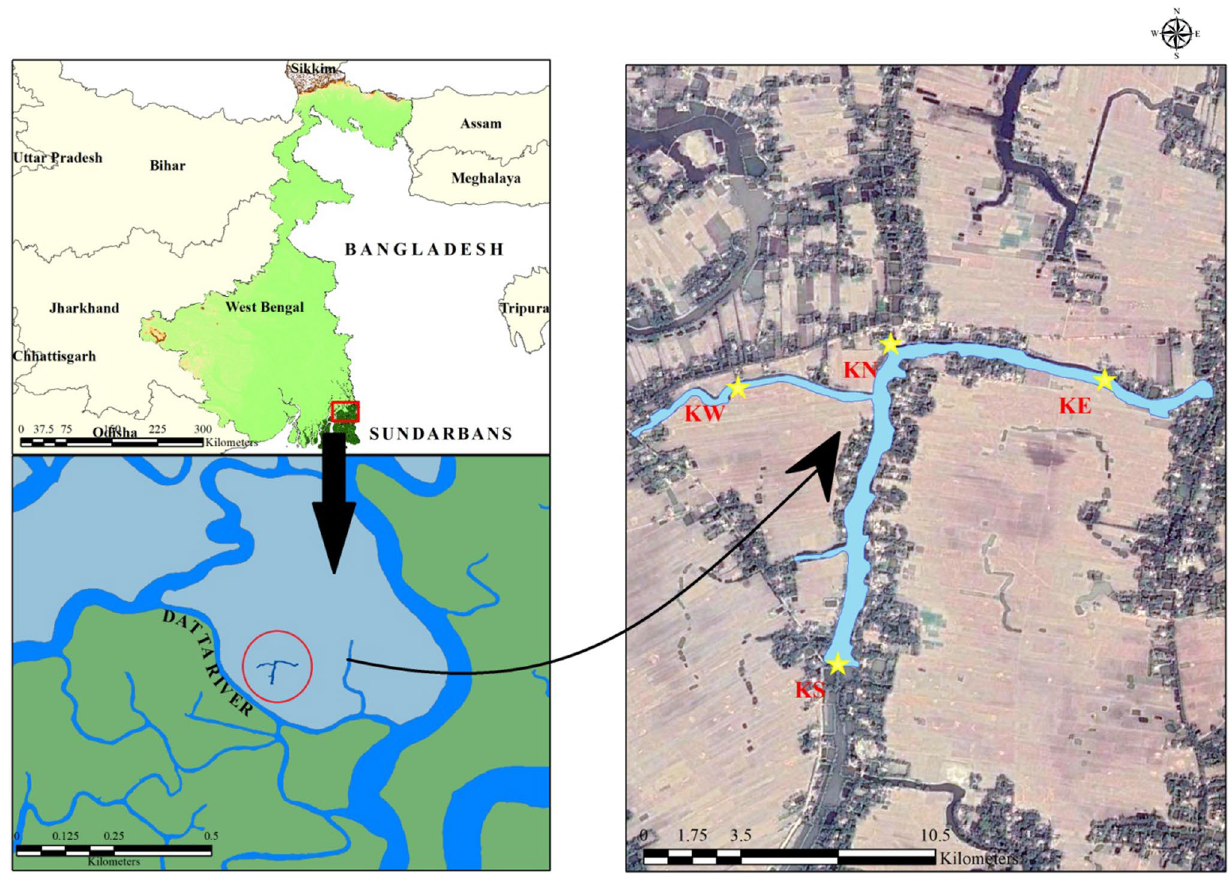
Fig. 1 Map of Kailash Khal , Anpur, Sundarbans; KS— Kailash Khal south; KN— Kailash Khal north; KE— Kailash Khal east; and KW— Kailash Khal